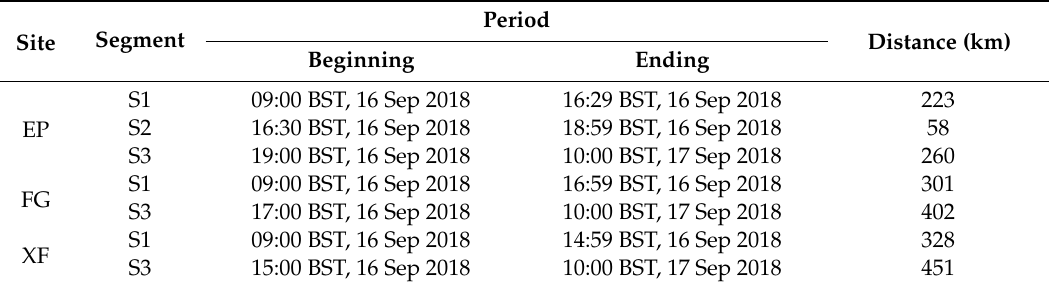
Table 1. Duration of the three segments observed by the three 2DVDs.